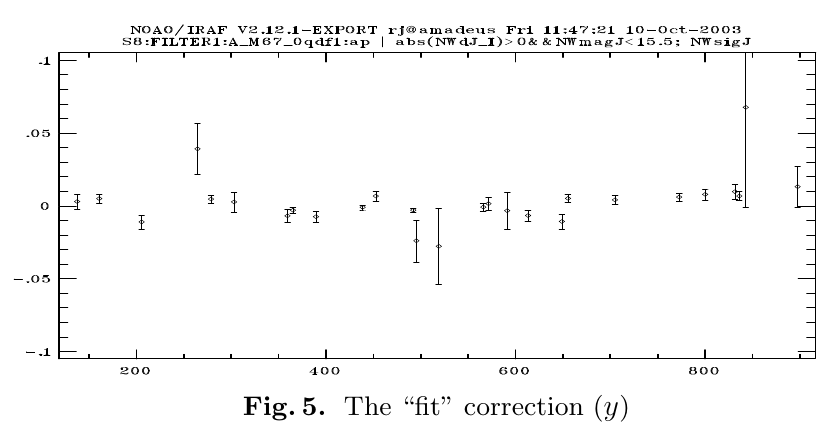
Fig. 5. The “fit” correction ( y